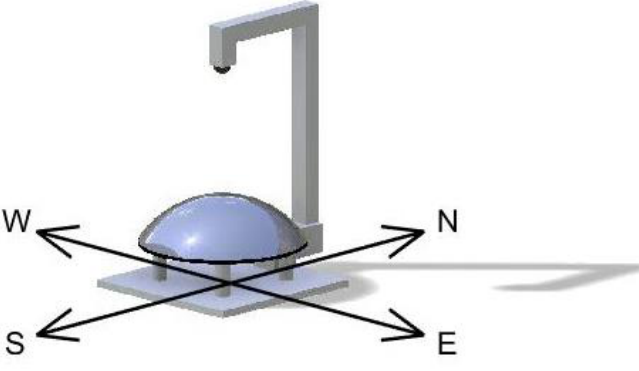
Figure 5. Acquisition system for the sky images: the camera (in black) records the sky image that is reflected on the convex mirror. The orientation of the device is also